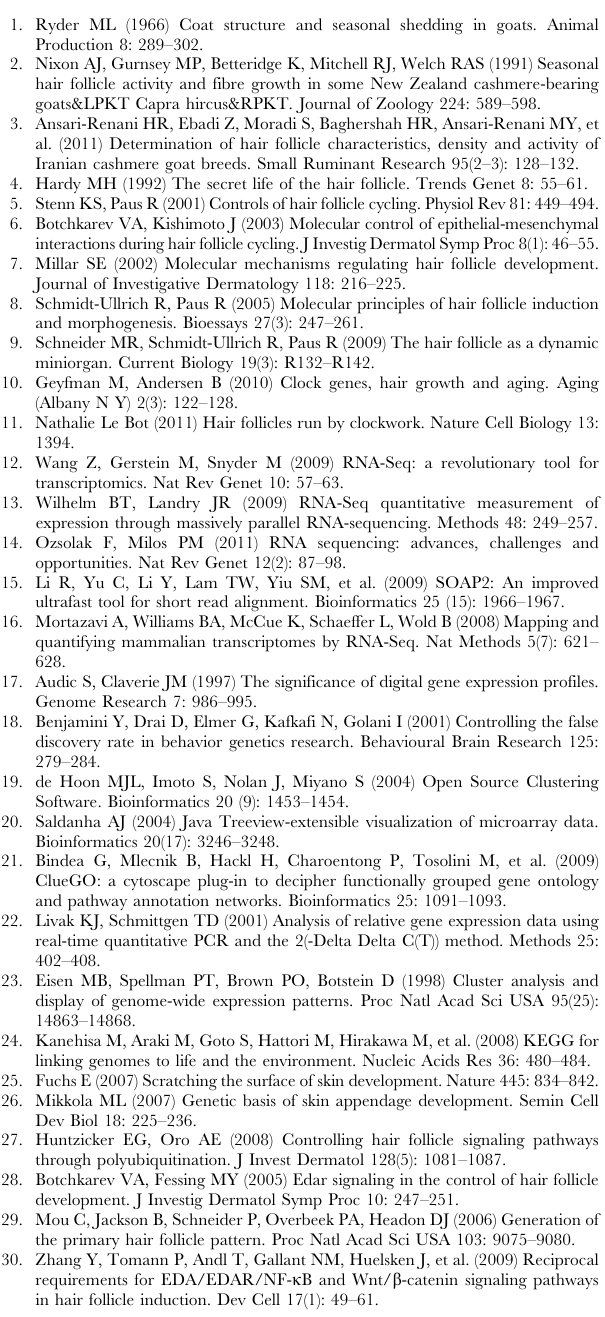
Table S1 Differentially expressed genes between ana- gen and catagen. Table S2 Differentially expressed genes between ana- gen and telogen.